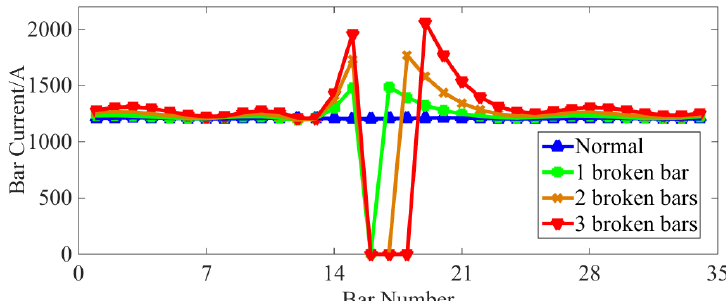
Figure 6. Current change in each bar.